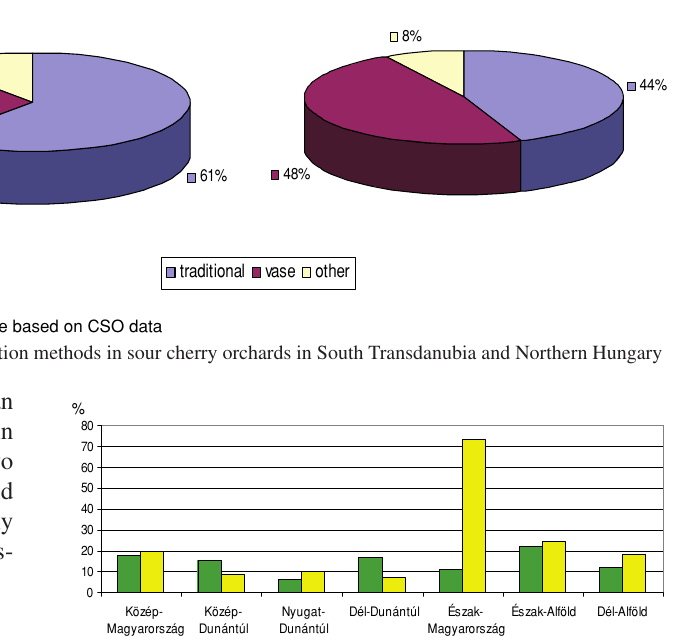
apple sour cherry Source: Own figure based on CSO data Figure 11: Relative deviations per fruit species and growing districts